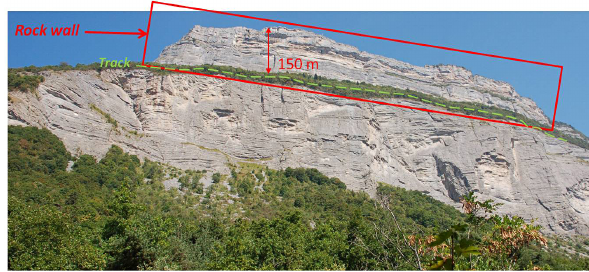
Fig. 5. Saint-Eynard calcareous cliff, near